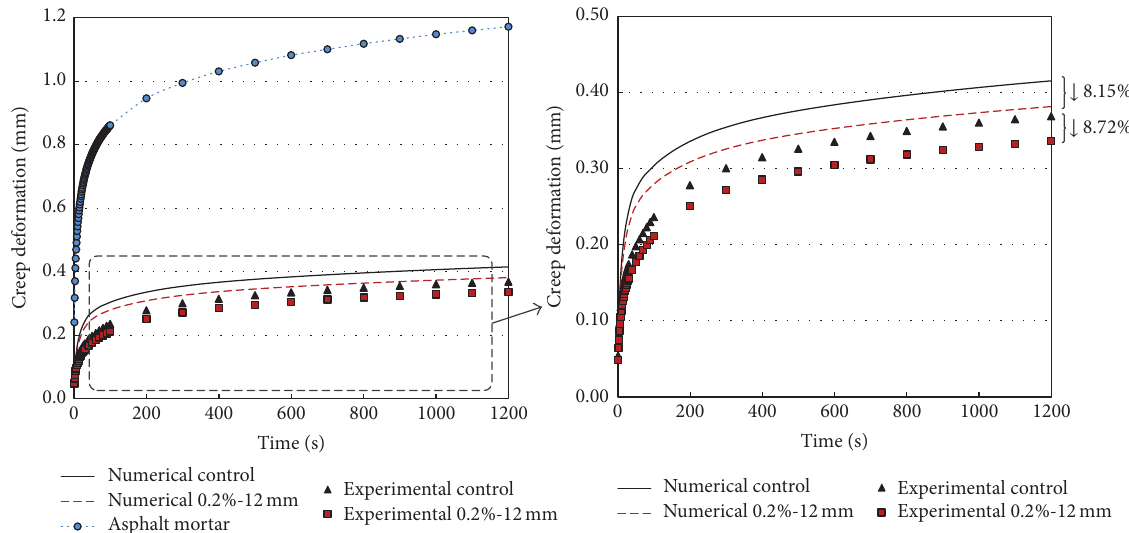
Figure 11: Comparison of experimental and numerical results.